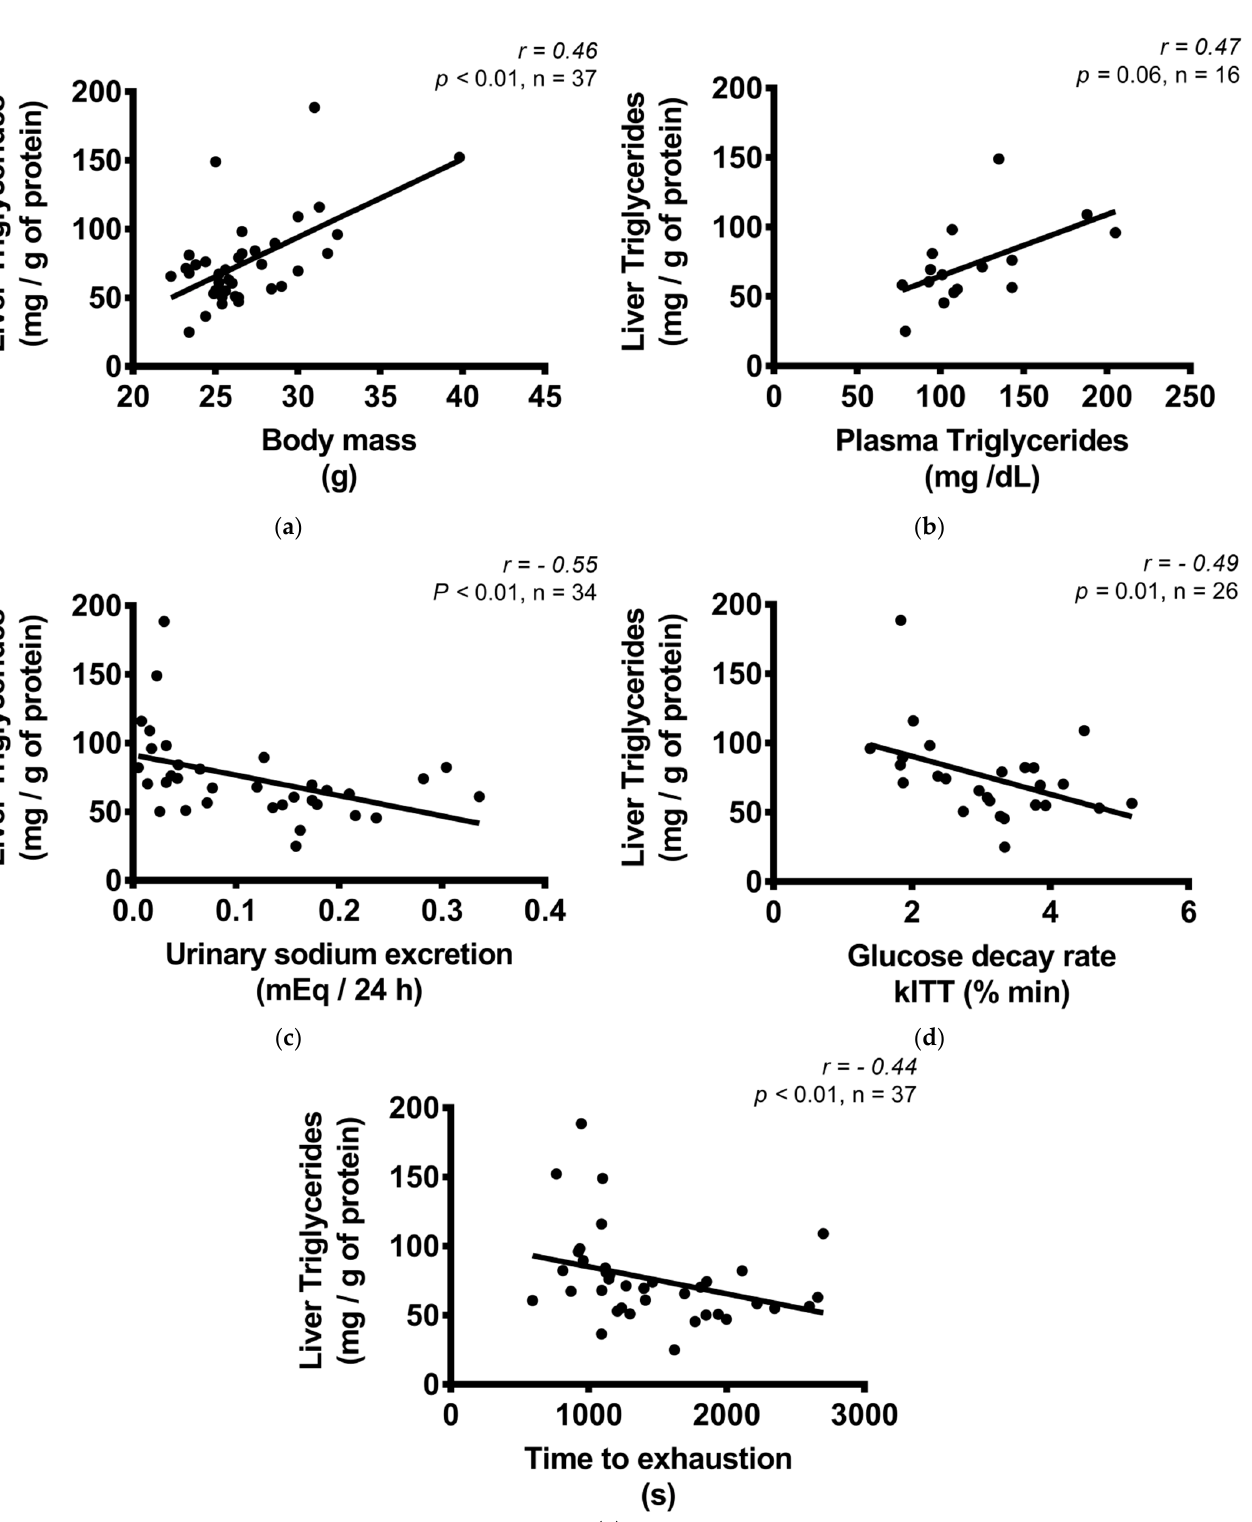
Figure 6. Correlation between liver triglycerides (mg/g of protein) and body mass, biochemical variables, and exercise treadmill test. ( a ) Liver triglycerides (mg/g of protein) and body mass (g); ( b ) liver triglycerides (mg/g of protein) and plasma triglycerides (mg/dL); ( c ) liver triglycerides (mg/g of protein) and urinary sodium excretion (mEq/24 h); ( d ) liver triglycerides (mg/g of protein) and glucose decay rate, kITT (% min); ( e ) liver triglycerides (mg/g of protein) and time to exhaustion in treadmill exercise test (s). Correlations were performed by the Spearman’s rank correlation test.